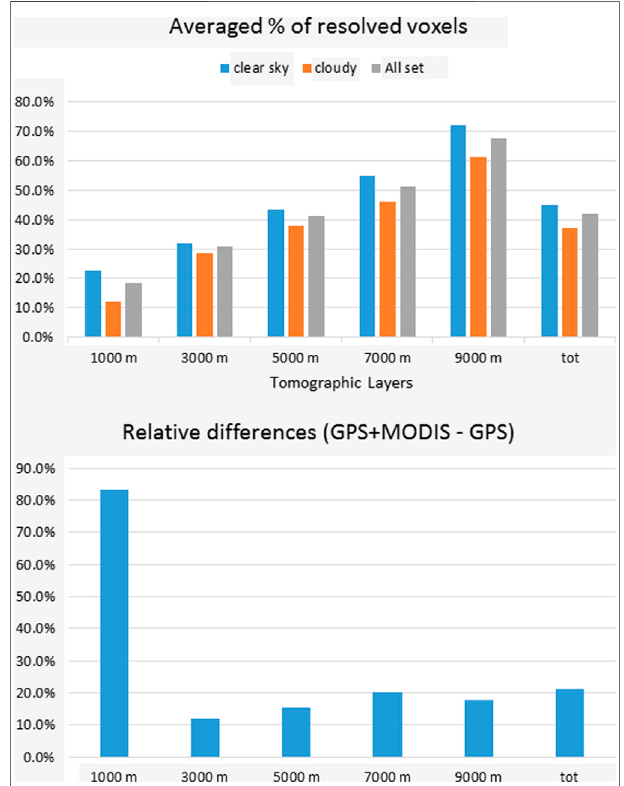
FIGURE 8 | Resolved Voxels Statistics. In the upper histogram, the averaged percentage ofthe resolved voxels areplotted, forthe different layers (1,000 m, 3,000 m, 5,000 m, 7,000 m, and 9,000 m) and thewhole set ofthe tomographies; the “ clear sky ” valuesrefertothe18May, 17July,and 22 August tomographies; the “ cloudy ” values refer to the 21 October and 26 Novembertomographies; “ allset ” valuesrefertoalltomographies.Inthelower histogram, the relative difference between “ clear sky ” (GPS + MODIS) and “ cloudy ” (GPS) vs. “ cloudy ” (GPS) tomographies, for the different layers (1,000 m, 3,000 m, 5,000 m, 7,000 m, and 9,000 m) and thewhole set ofthe